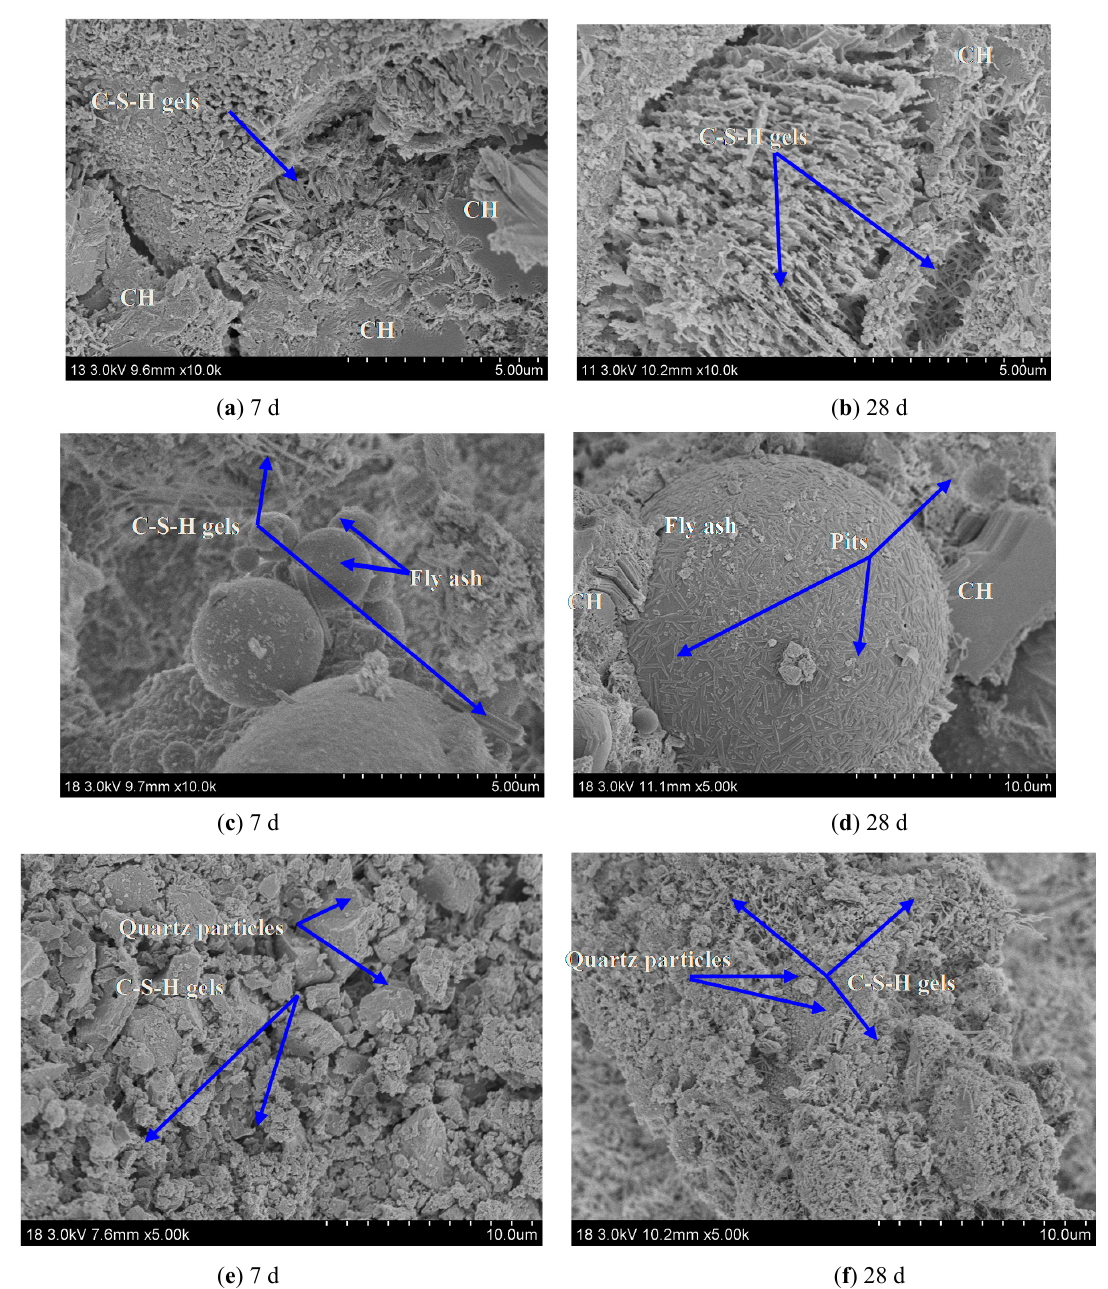
Figure 5. Micrographs of the hardened pastes with F and Q at different curing ages ( a ) hardened paste of pure cement at 7 d; ( b ) hardened paste of pure cement at 28 d; ( c ) hardened paste with F at 7 d; ( d ) hardened paste with F at 28 d; ( e ) hardened paste with Q at 7 d; ( f ) hardened paste with Q at 28 d